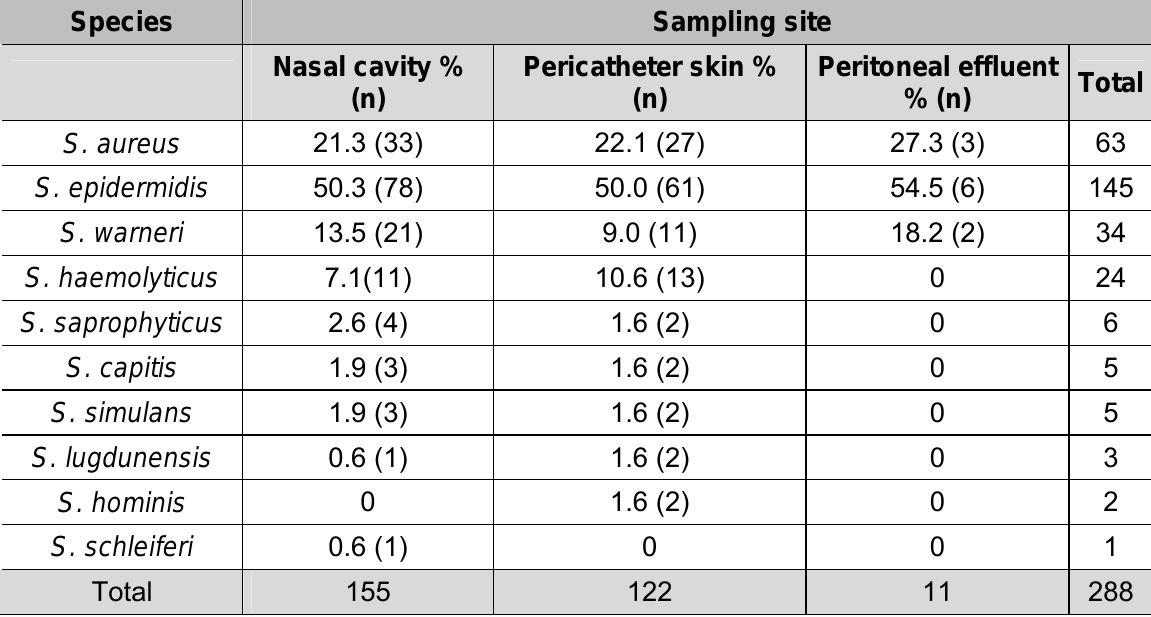
Table 2. Distribution of Staphylococcus isolated from the nasal cavity, pericatheter skin and peritoneal